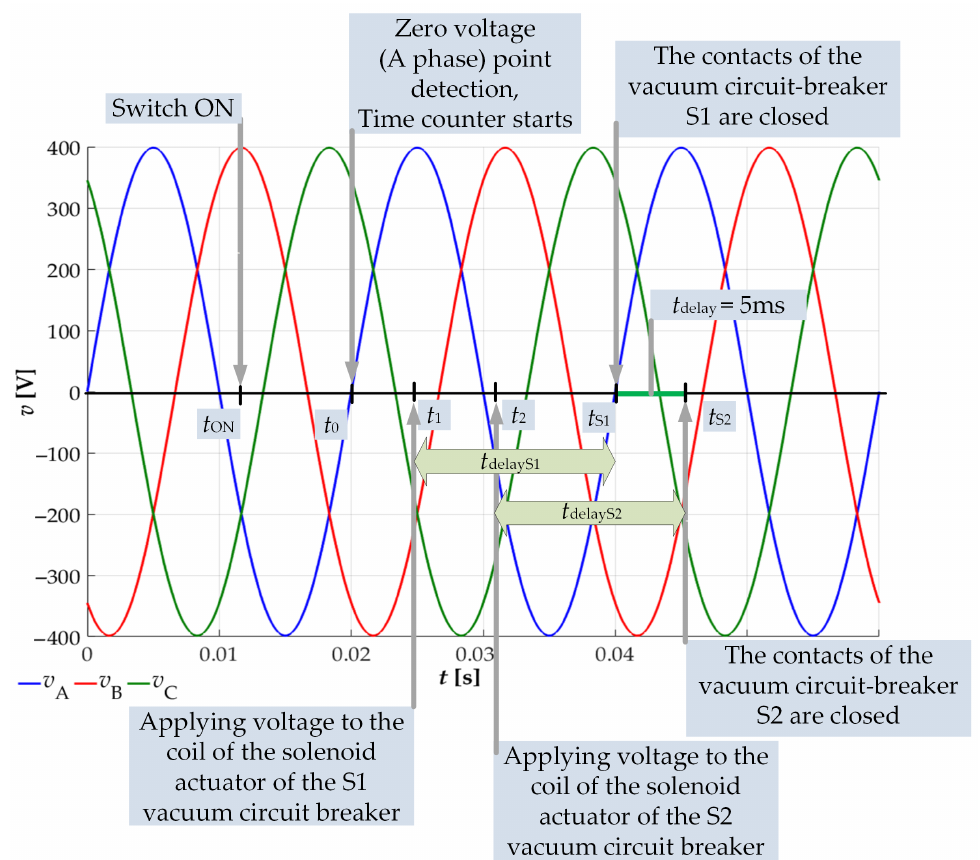
Figure 16. Algorithm for switching on an induction motor by vacuum circuit